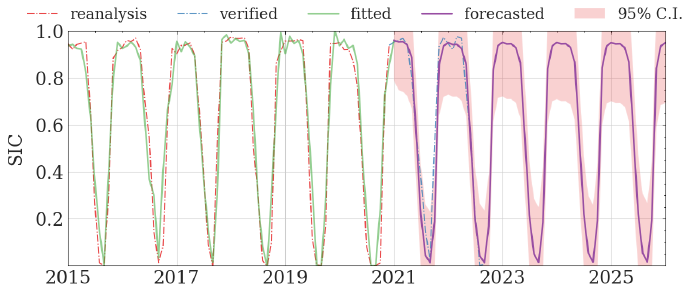
Figure 16. The estimated and forecasted SIC values from the ARIMA model in sub-region No. 2.